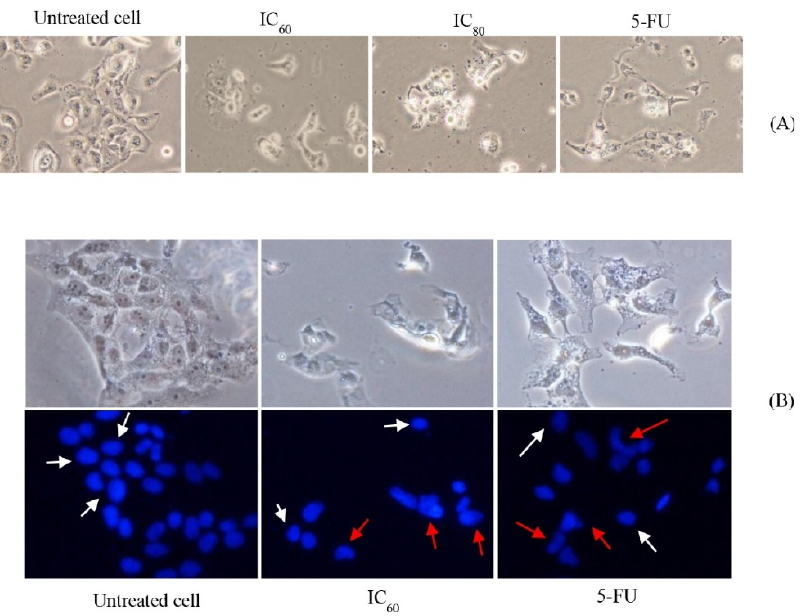
Figure 3. ( A ) Microscopic image of KON cancer cells exposed to NE and 5-FU. ( B ) Fluorescent im- ages of KON cancer cells after treatment with control, NE (80:20) at IC60 concentration, and 5-FU; White and red arrows show normal nucleus and nucleus fragmentation, respectively [73].